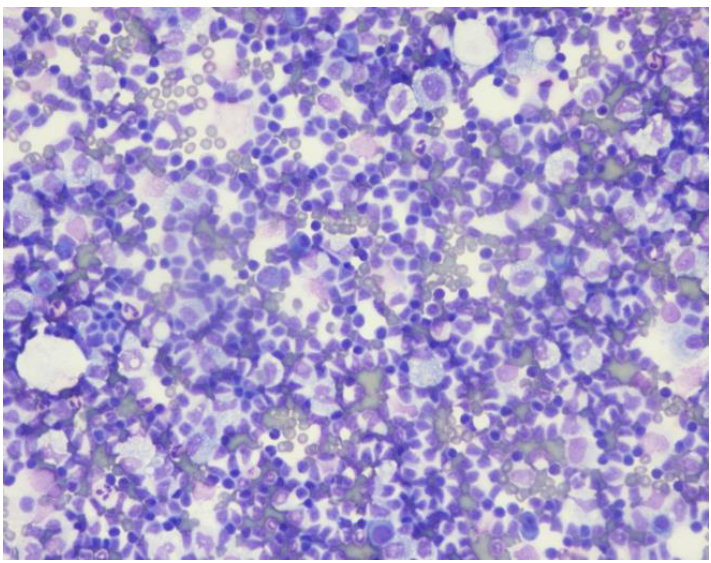
Figure 1. Peritoneal fluid with an increased lymphocyte population.